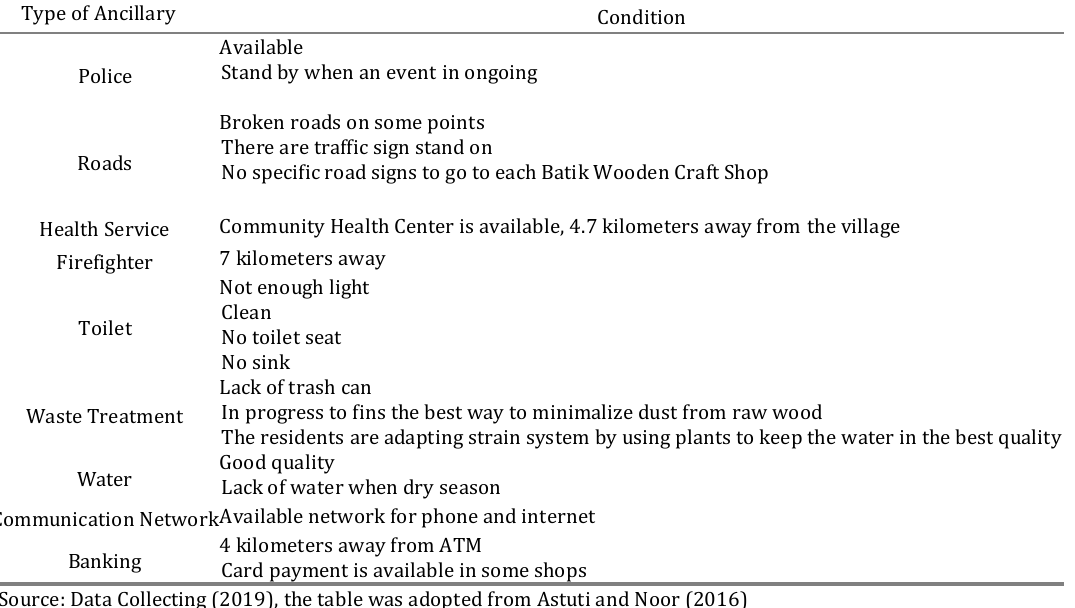
Table 4 Amenities in Krebet Tourism Village